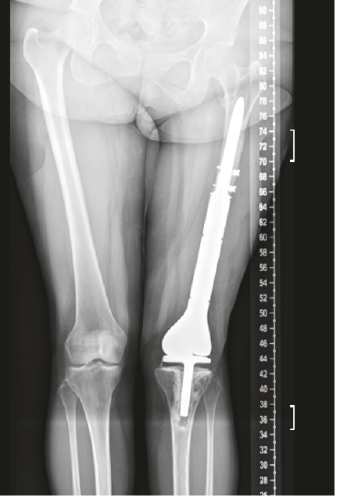
Figure 8: Postoperative AP radiograph with endoprosthesis recon-